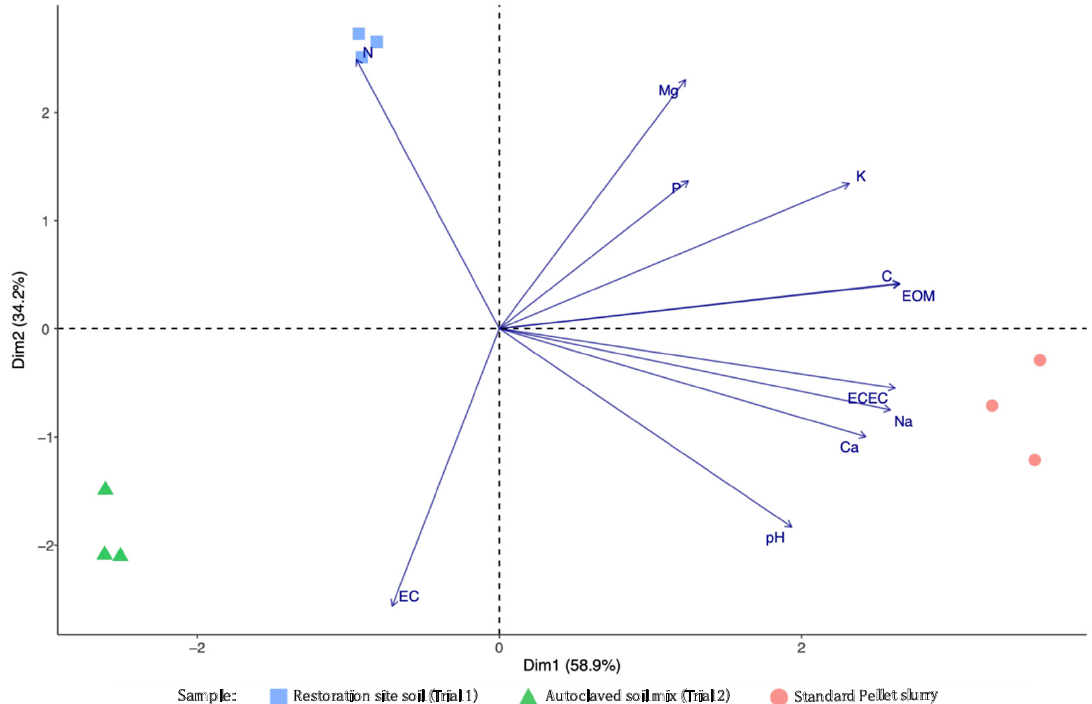
Figure 2 . Principal Component Analysis biplot of the nutrient and physicochemical properties of samples from the two soil types and the mixture used to make the standard extruded seed pellets. Symbols represent the scores of triplicate samples; vectors represent the loadings of variables (nutrient/physicochemical parameters). C: total carbon; Ca: exchangeable calcium; EC: electrical conductivity; ECEC: effective cation exchange capacity; EOM: estimated organic matter; K: exchangeable potassium; Mg: exchangeable magnesium; N: total nitrogen; Na: exchangeable sodium; P: phosphorus.